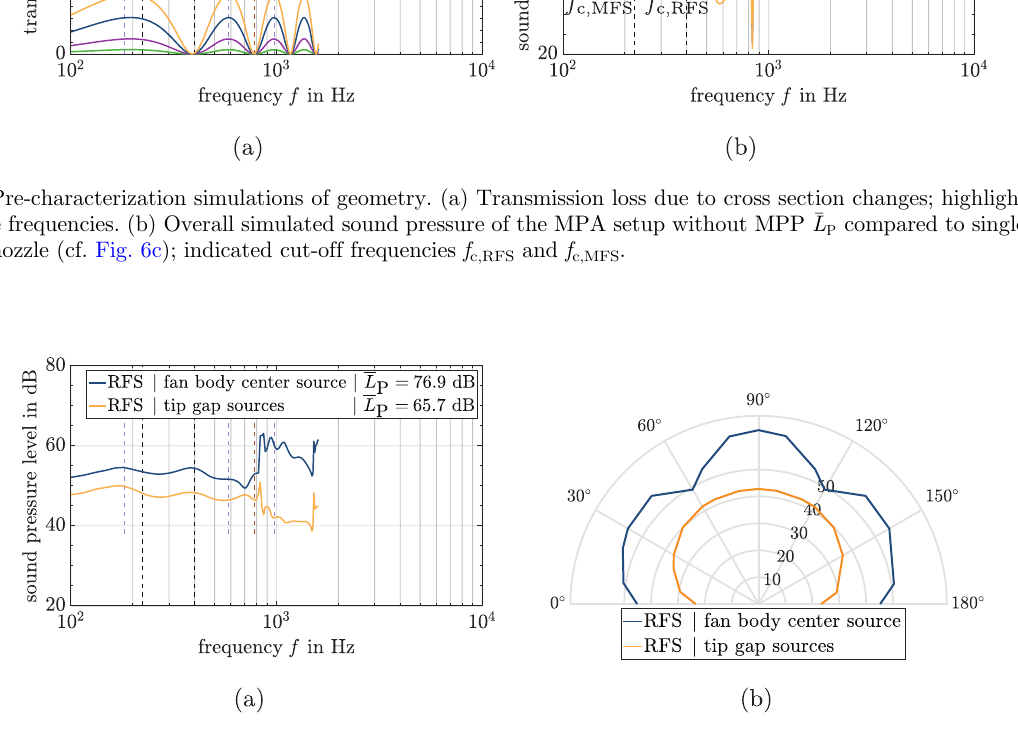
Figure 11. Simulated radiation pattern and strength of point sources located on the fan body center axis and in the blades ’ tip gap region. (a) Simulated sound emission spectra of varied point source location for the reference setup. (b) Simulated sound emission directivity pattern at 1200 Hz with sound pressure level